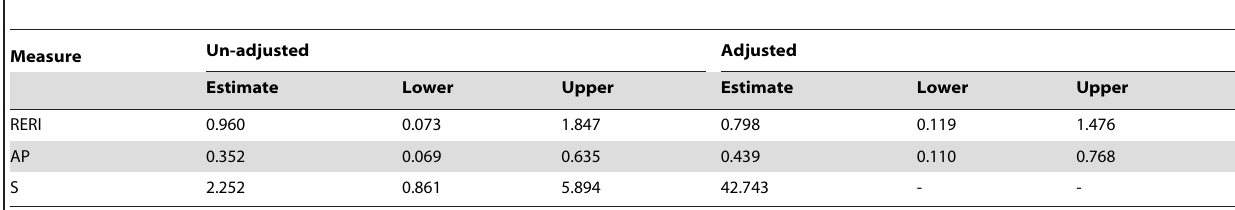
Table 4. Indexes of additive biological interactive effect of obesity and central obesity on elevated urinary albumin-to-creatinine